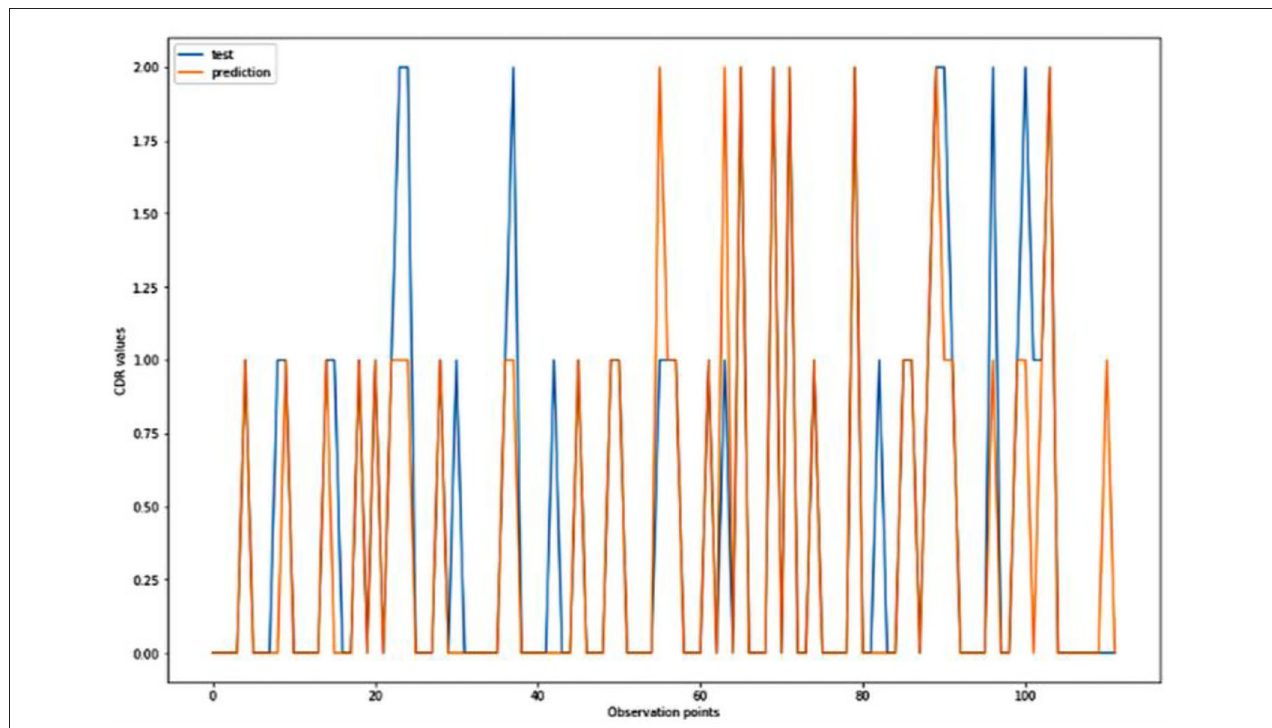
FIGURE 7 | Graphical representation of the comparison of test and predicted CDR values obtained using the k-neighbors classification algorithm. (11 parameters).